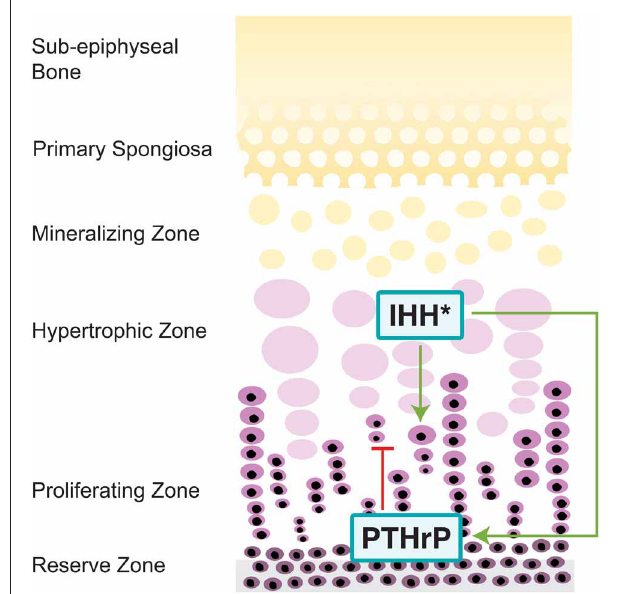
FIGURE 3 | Hedgehog pathway in the cranial base. IHH, expressed in the pre-hypertrophiczones of growth plates, increases chondrocyte proliferation through increased expression of PTCH, a process mediated by intracellular component EVC (Long et al., 2001; Ruiz-Perez et al., 2007; Pacheco et al., 2012). Through a negative feedback loop, IHH also delays chondrocyte differentiation in order to sustain early chondrocyte production through synthesis of PTHrP, an IHH inhibitor (Lanske et al., 1996; Vortkamp et al., 1996; Kronenberg, 2003). ∗ IHH also regulates craniofacial morphogenesisthrough altering the IHH/PTHrP negative feedback loop, though it is primarily expressed in the spheno-occipital synchondroses (Tavella et al.,